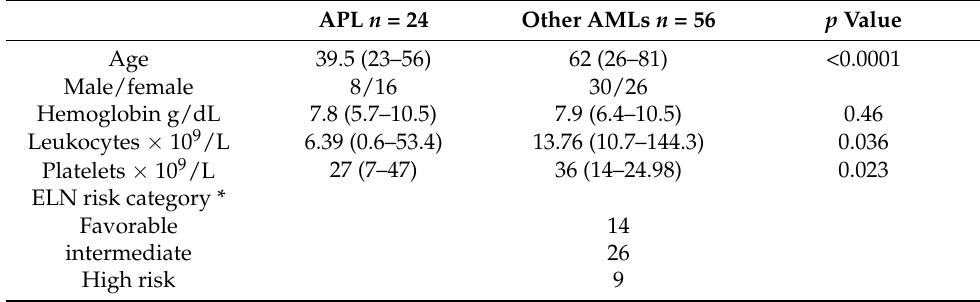
Table 1. Demographic characteristics of the patients. Median (percentiles 10–90%).